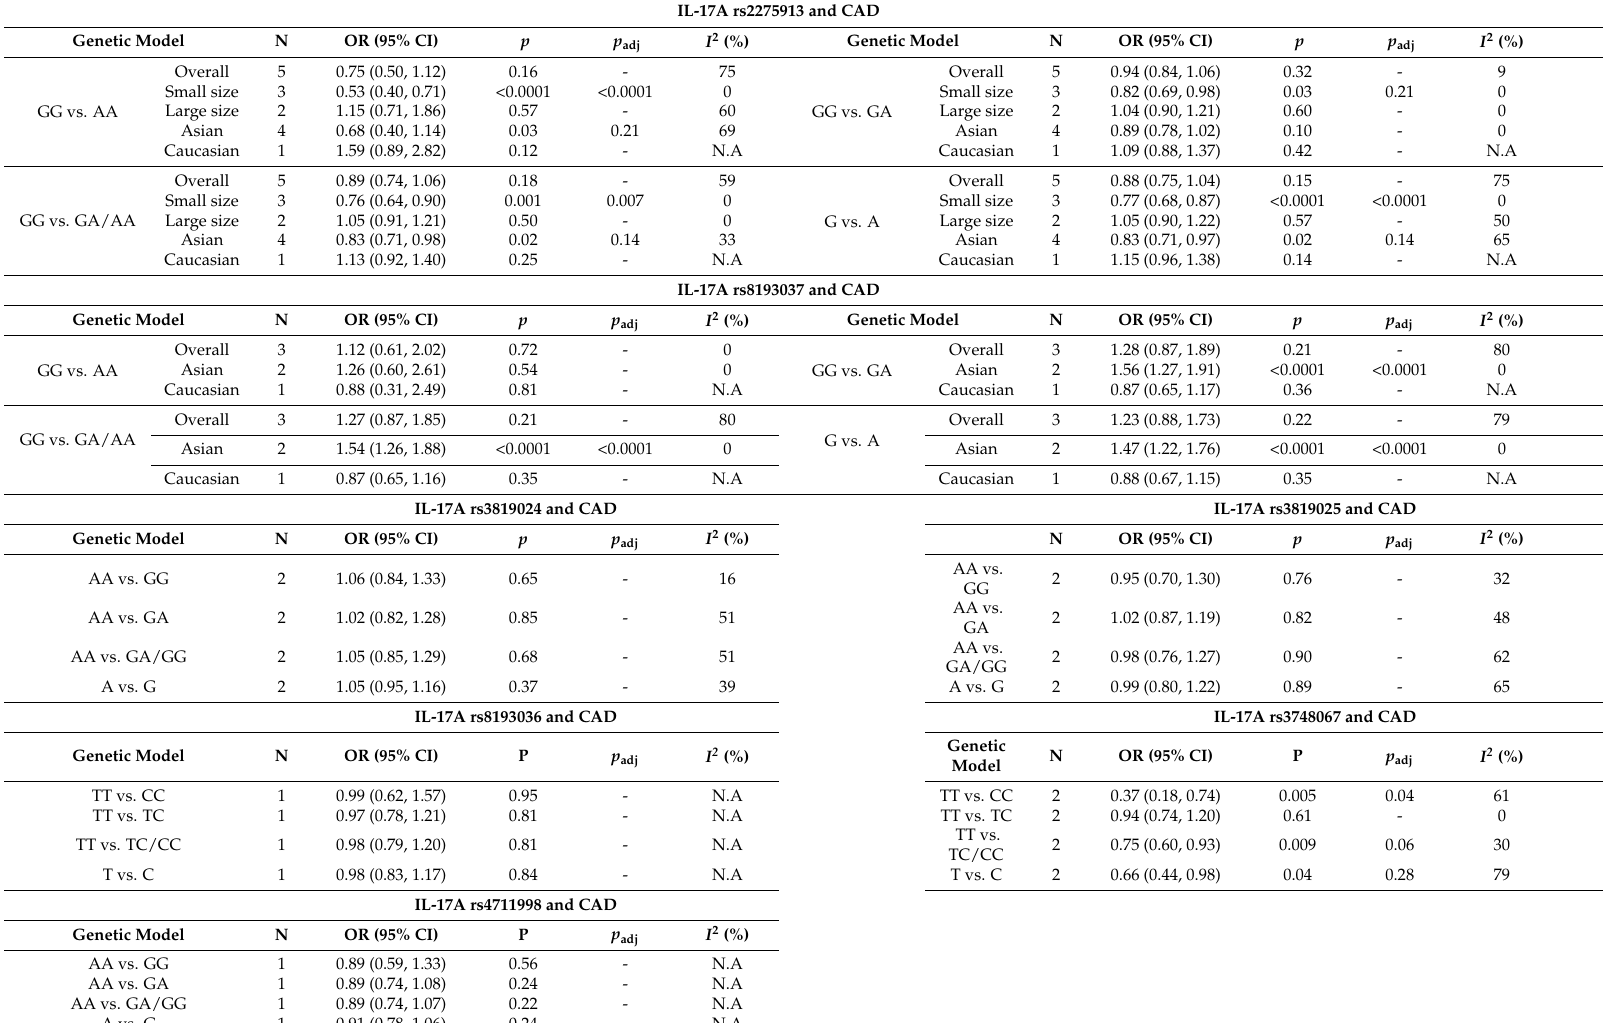
Table 2. Pooled ORs and 95% CIs of the association between IL-17A rs2275913, rs3819024, rs3819025, rs8193037, rs3748067, rs4711998, rs8193036, and CAD risks. IL-17A rs2275913 and CAD